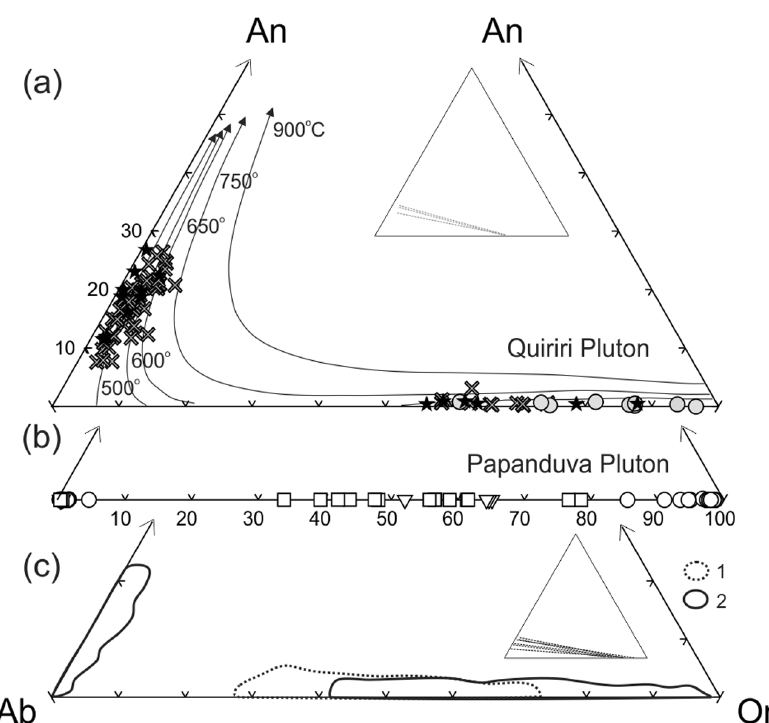
Figure 9 - Average compositions of core, intermediate zone and rim for alkali feldspar and albite, and individual chemical analysis of plagioclase in the An-Ab-Or molecular ternary plot for representative samples of the Quiriri (a) and Papanduva (b) Plutons. Available chemical data for feldspars from other plutons of the Graciosa Province are shown for comparison (c) : plutons of the alkaline (1) and aluminous (2) associations in the Serra da Graciosa region (Gualda and Vlach 2007b). Solvus curves for Ptotal = 100 MPa, according to the model after Fuhrman and Lindsley (1988). Inset ternary plots in (a) and (c) show compositions of coexistent plagioclase and alkali feldspar crystals. Symbols as in Fig.